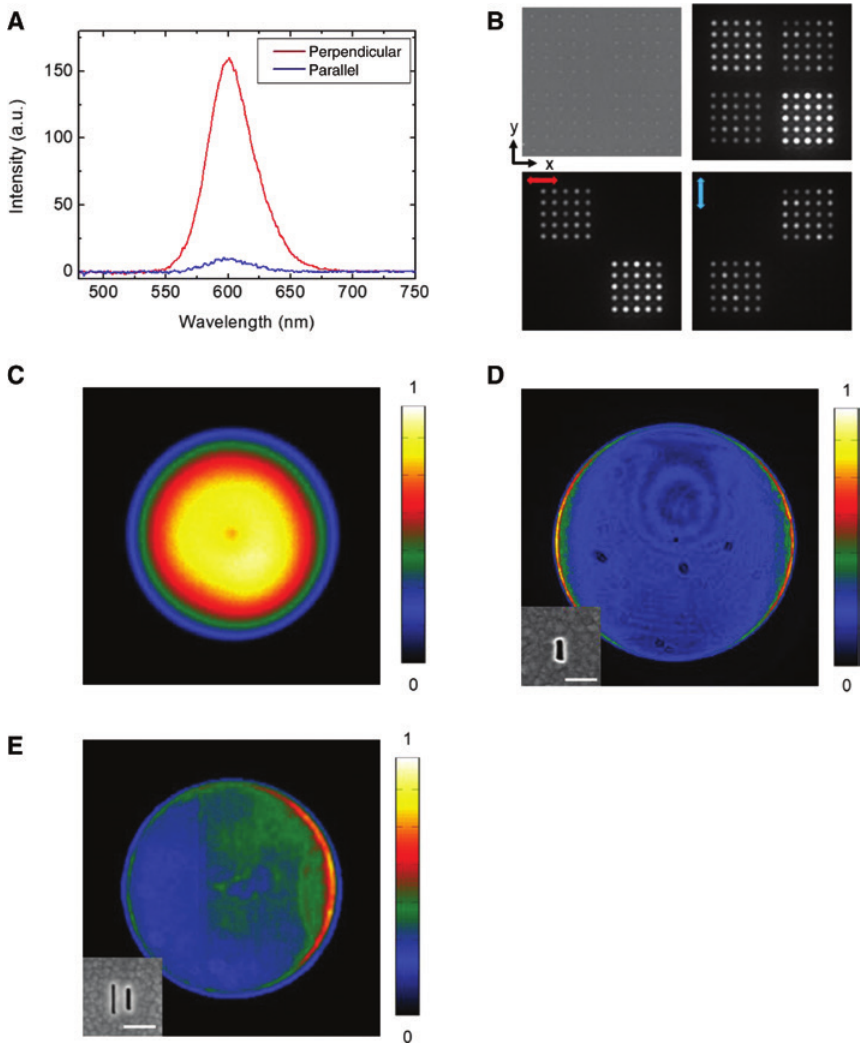
Figure 15: Properties of emission from antenna-integrated LEDs. (A) EL spectra from antenna-integrated LEDs measured while changing the direction of detection of polarization. (B) SEM image of antennas with the x - and y -directions (top left) and optical image of EL from LEDs with antenna-integrated electrodes (top right). Optical images of EL from LEDs measured by the polarizer along the x -direction (bottom left) and y -direction (bottom right). (C) Measured Fourier space image of emissions from LEDs without antenna. (D) Measured Fourier space image of emissions from LEDs with single slot antenna. (E) Measured Fourier space image of emissions from LEDs with slot-groove antenna. The white lines in the SEM images correspond to 200